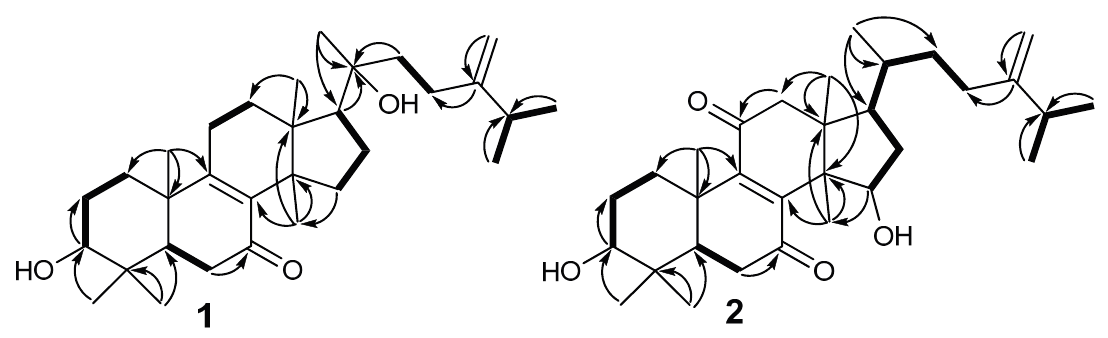
Figure 2. 1 H- 1 H COSY ( ) and Key HMBC ( ) correlations of 1 and 2 .